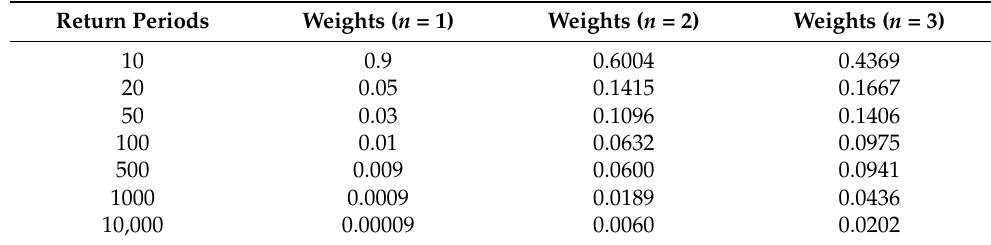
Table 1. Proposed weights based on floods probabilities of occurrence in three different